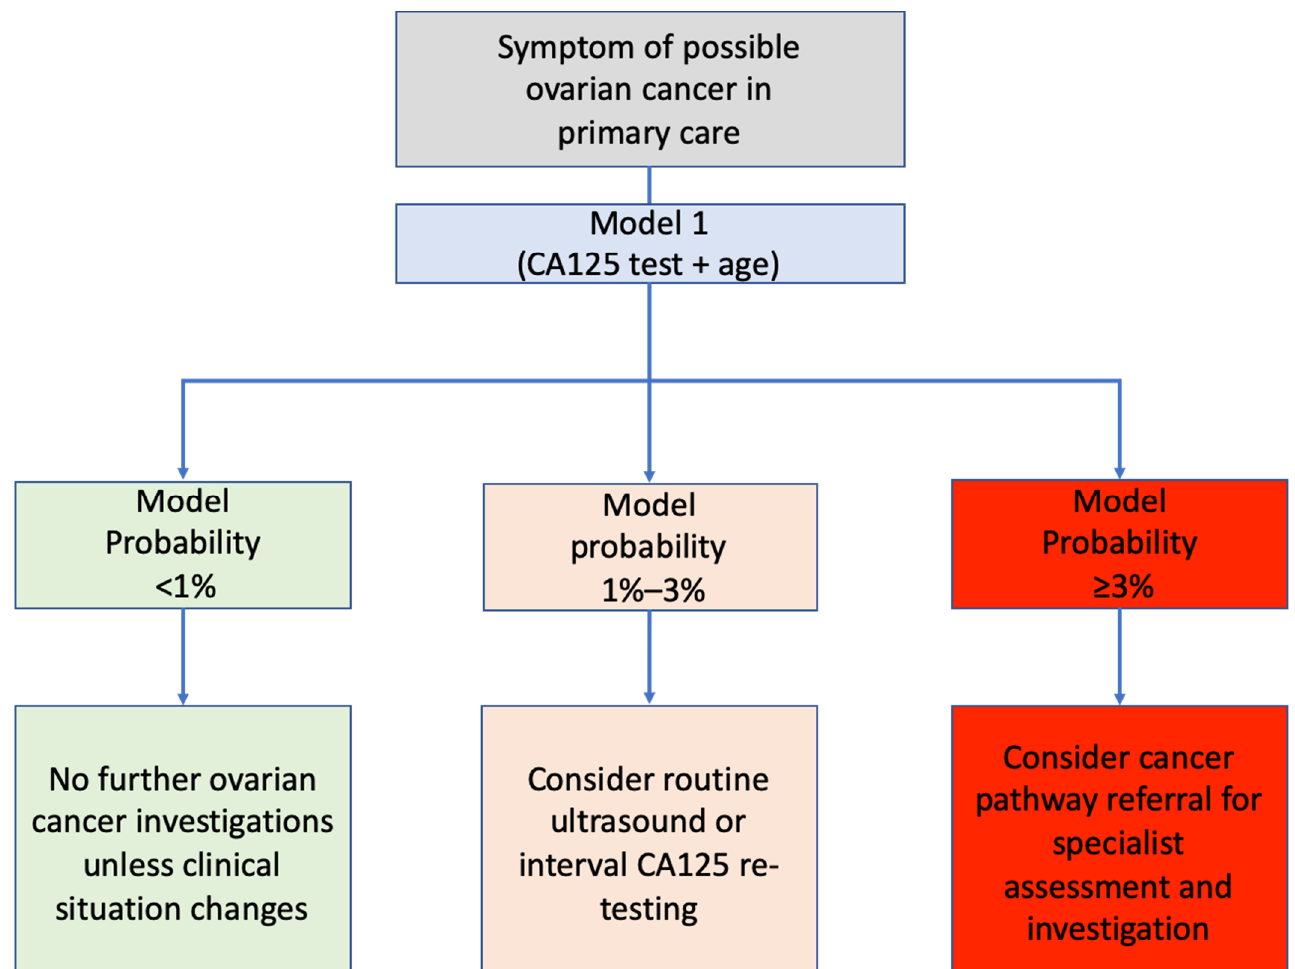
Figure 3. Example risk-based triage system employing model probability thresholds.